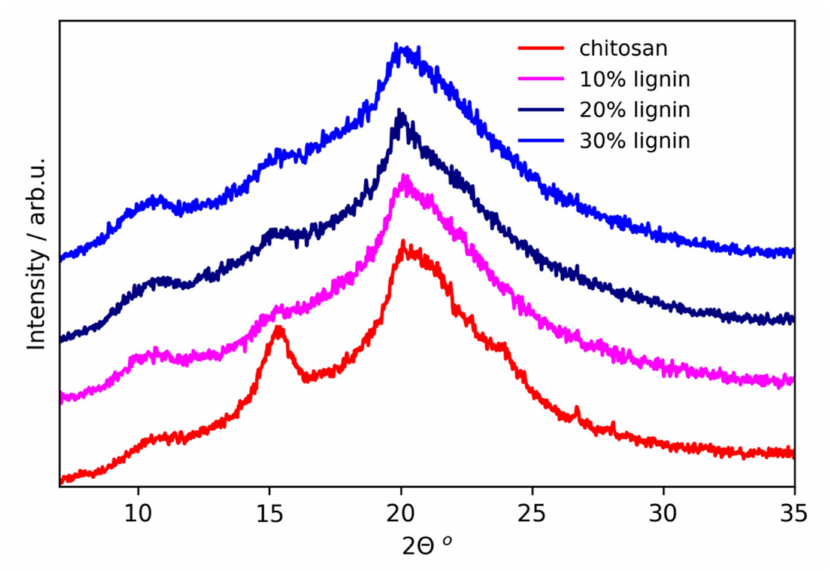
Figure 3. The WAXD patterns of the chitosan film and composite films with different contents of